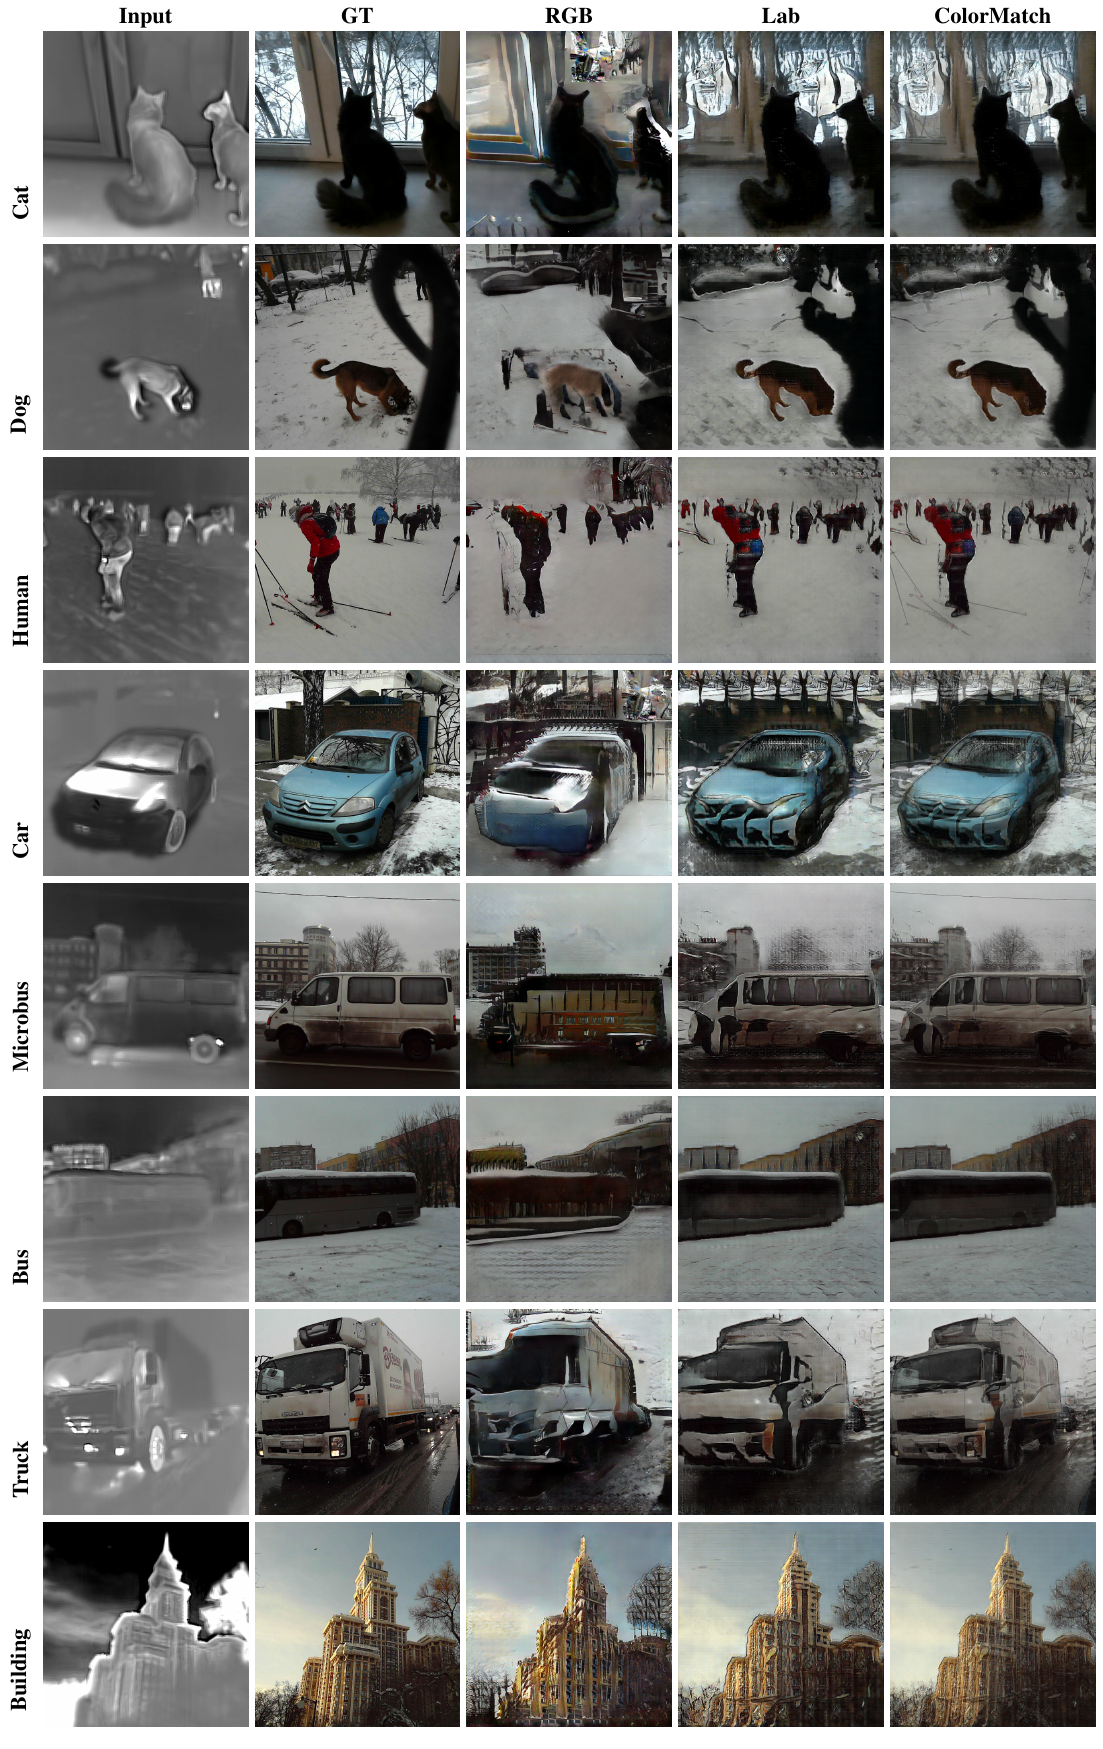
Figure 3. Qualitative colorization results for different classes and